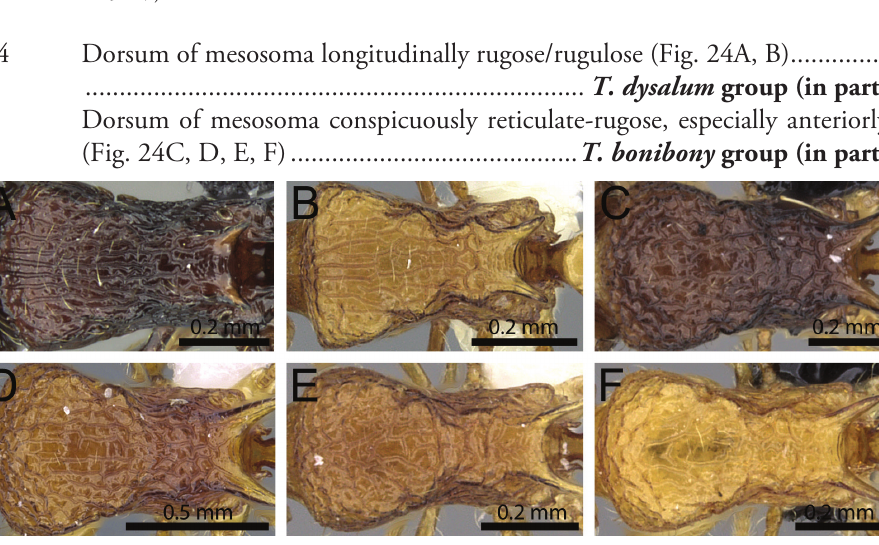
Figure 23. Petiole and postpetiole in profile. A T. sada (CASENT0443274) B T. nosybe (CASENT0422207) C T. olana (CASENT0044485) D T. mackae (CASENT0189093) E T. aherni (CASENT0045755) F T. alperti (CASENT0042547) G T. ambatovy (CASENT0124721) H T. avaratra (CASENT0445167).